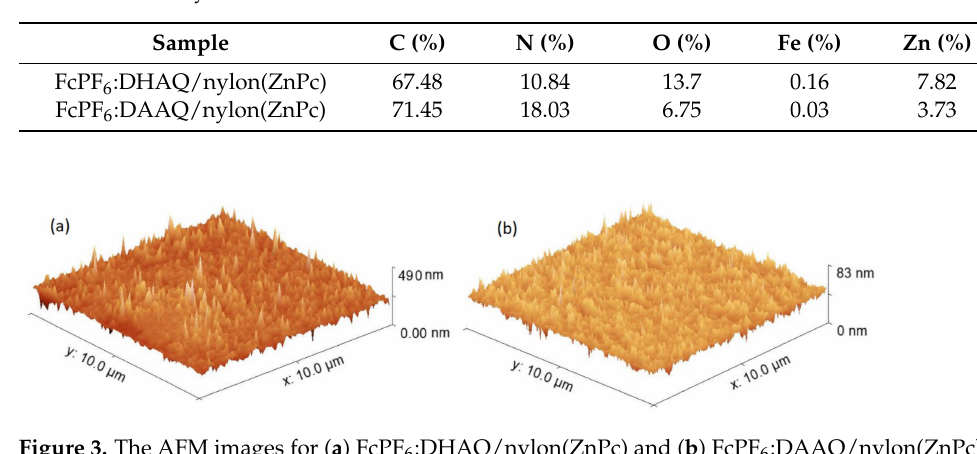
Table 1. EDS analysis of the heterostructures.